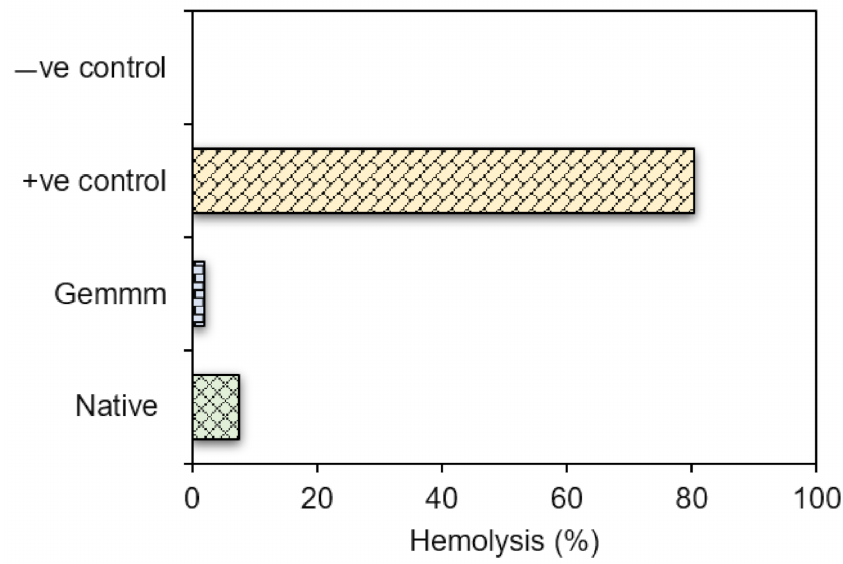
Figure 7. Hemolytic activity of Native and gemm extracts of H. griffithi